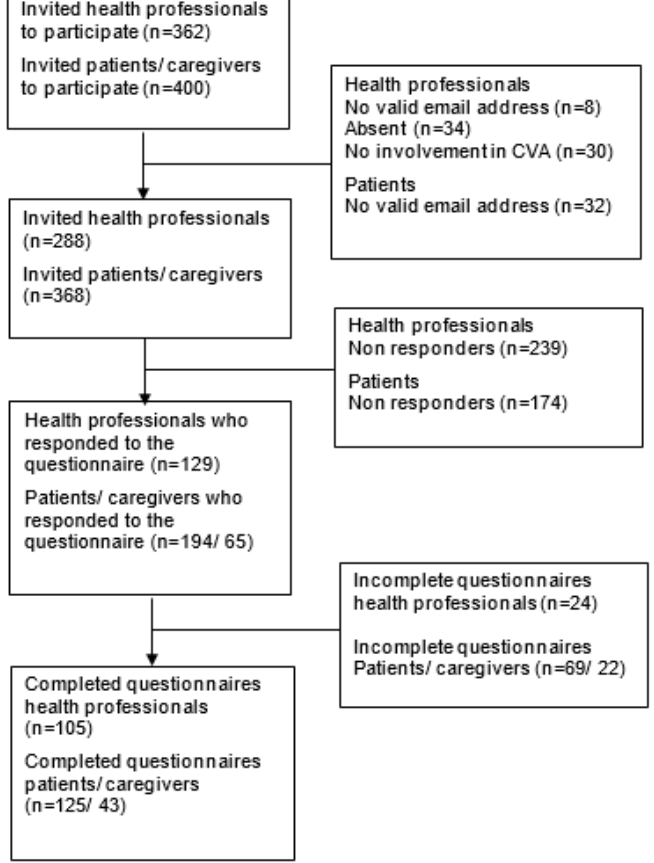
Figure 2. Flow of